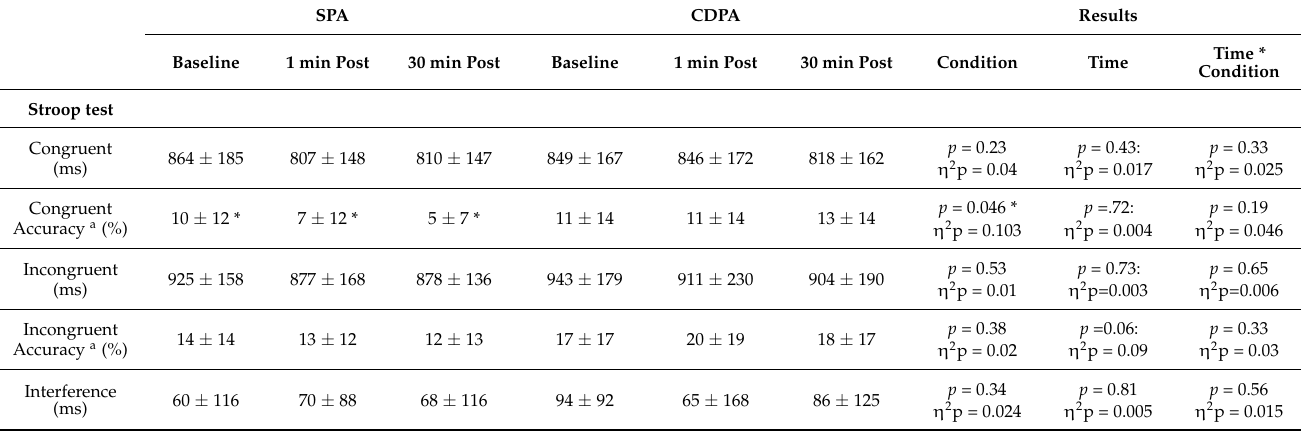
Table 2. Cognitive performance scores for the Stroop test in ms (M ±